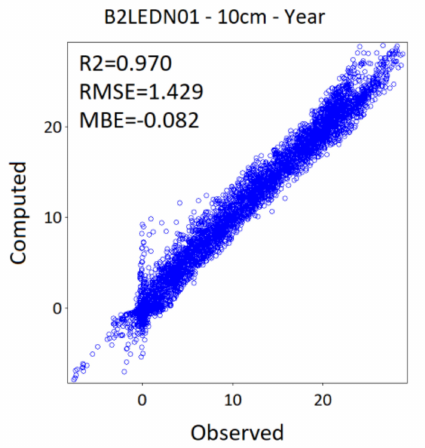
Figure A3. Validation at site B2LEDN01 for 10 cm soil depth.